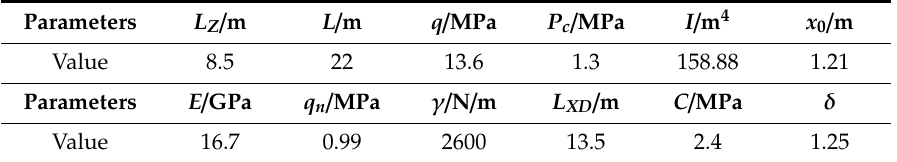
Table 1. Main parameters of the test